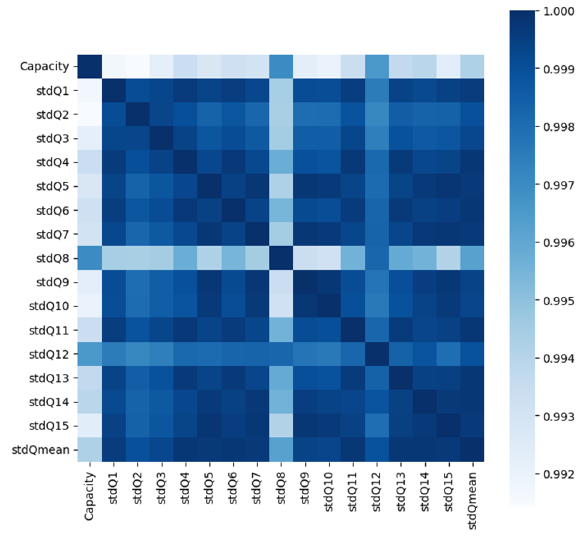
Figure 9. The correlation coefficient between stdQ and the capacity of each battery cell.